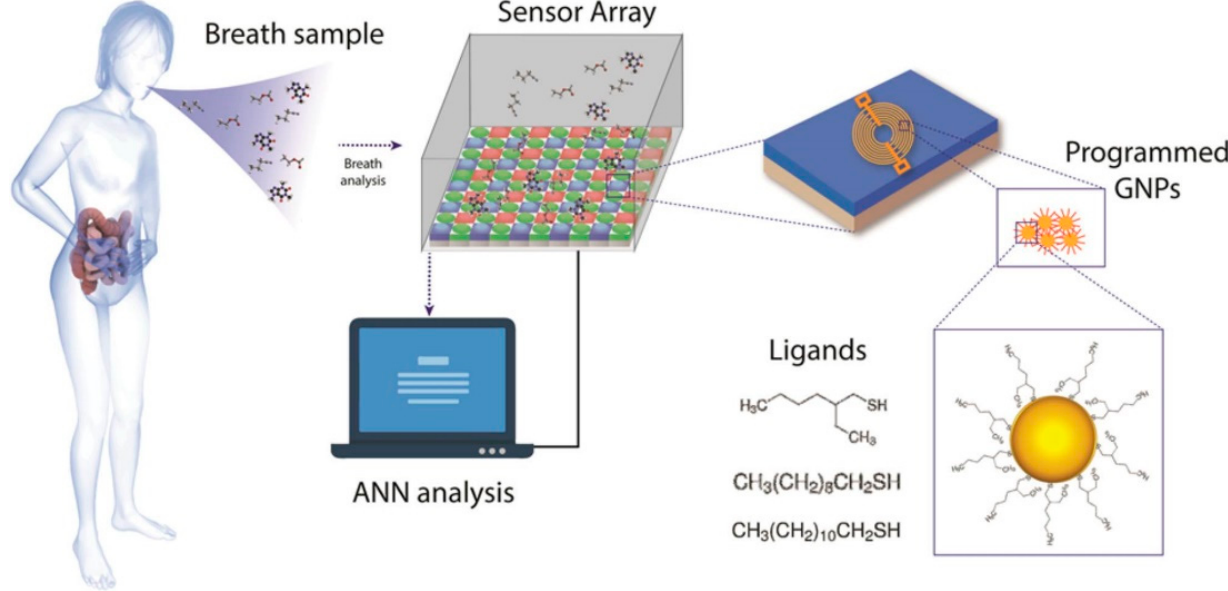
Figure 6. Schematic representation of a MCNPs-based chemiresistor, programmed according to the VOCs identified as inflammatory bowel and irritable bowel syndrome disease biomarkers. The sensor was exposed to simulated, HC and patient breath samples. Time-dependent and reversible shift in the sensor’s resistance is associated with the MCNPs–VOCs interactions. The variability of molecular ligands leads to varying sensing responses; pattern recognition methods such as ANN, permit the development of effective diagnostic classifiers. Reprinted with permission from ref. [111].